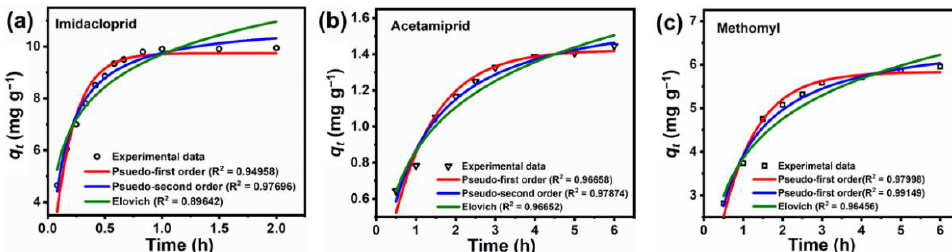
Figure 5. Adsorption kinetics of ( a ) imidacloprid, ( b ) acetamiprid and ( c ) methomyl on BC, respec- tively, by fitting pseudo-first order, pseudo-second order and Elovich models.